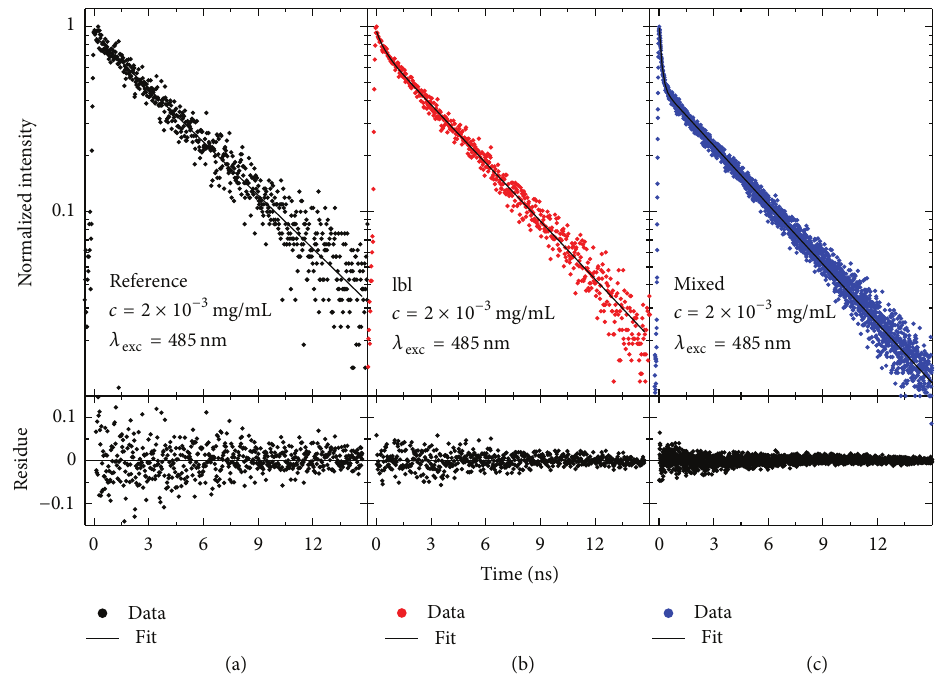
Figure 9: Typical fluorescence decay curves of (a) the reference and for hybrid nanostructures that contain the PCP complexes deposited on Ag nanowires prepared using (b) layer-by-layer and (c) mixed approaches. The samples were excited at 𝜆